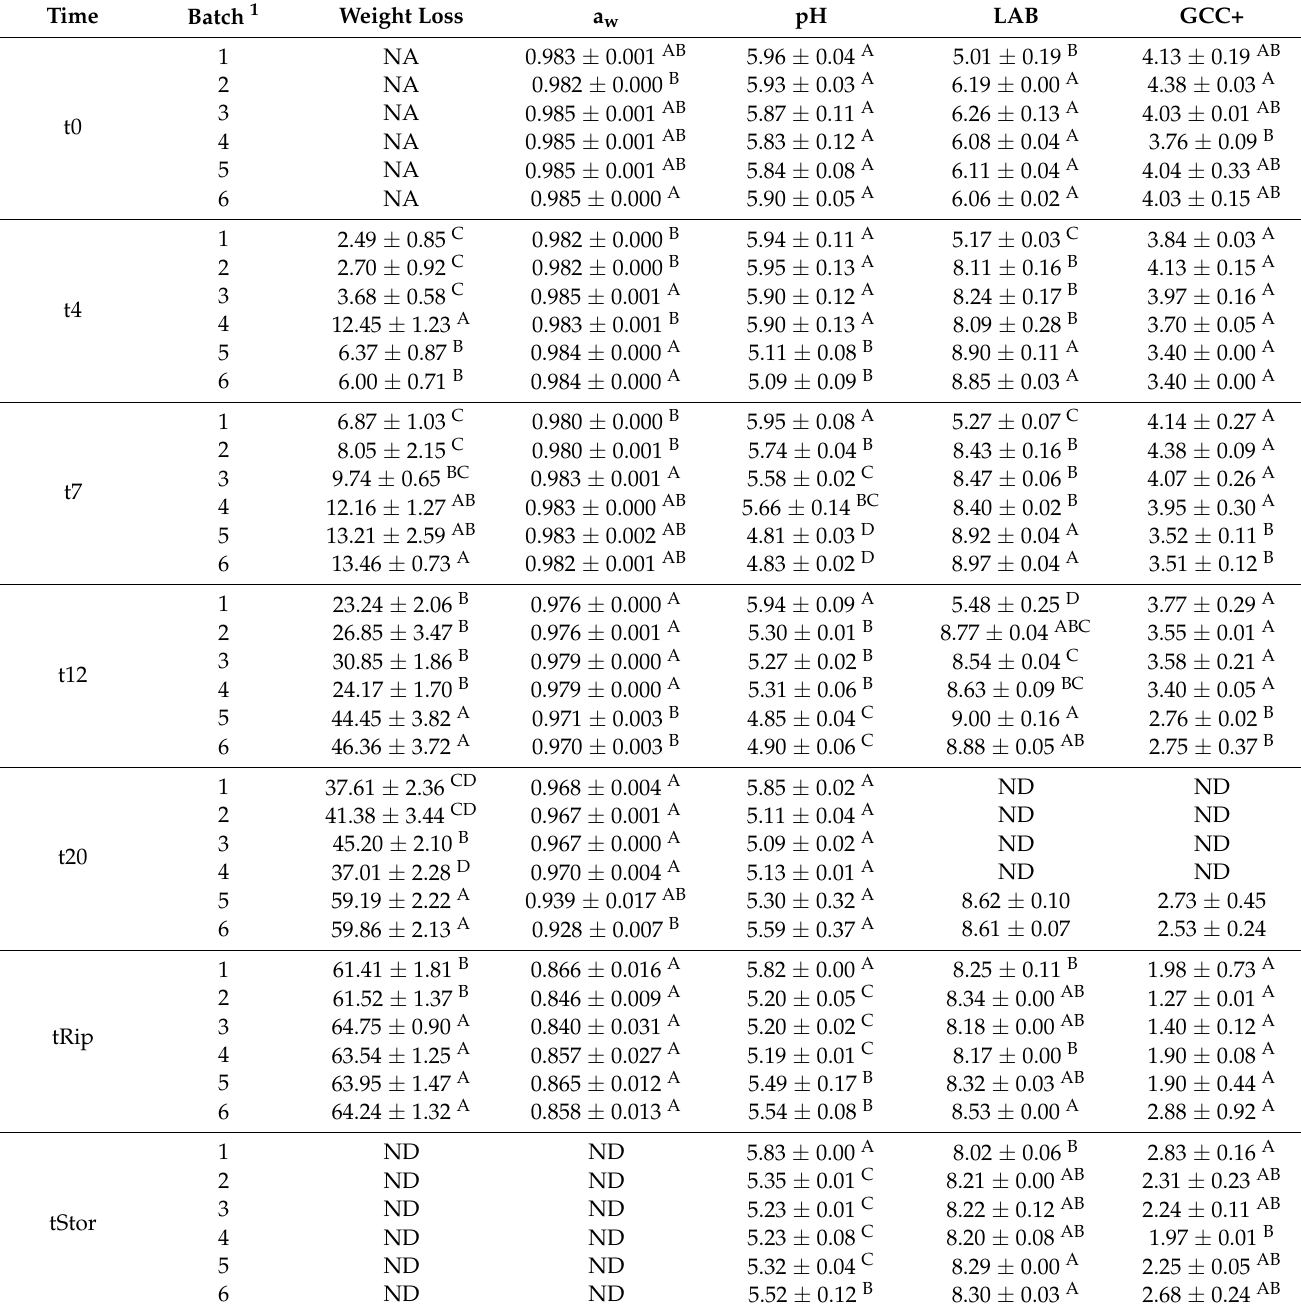
Table 2. Weight loss (%), physicochemical parameters, lactic acid bacteria (LAB) and Gram-positive catalase positive cocci (GCC+) counts (in log CFU/g). Values are the mean ± standard deviation for the replicates. Specifically, for each sampling time, significant differences between batches are marked with different capital letters ( p < 0.05). NA: Not applicable; ND: